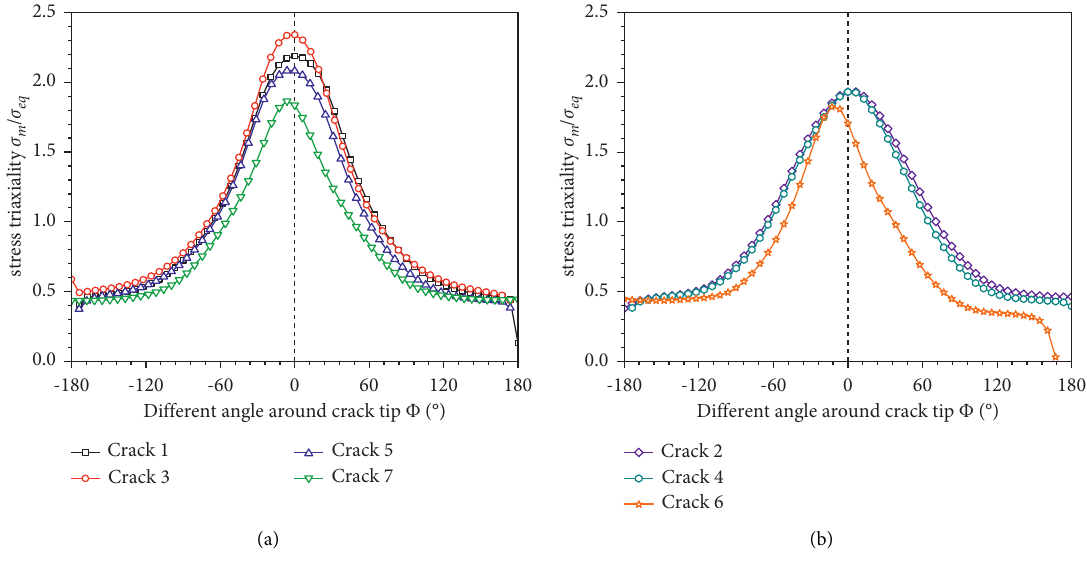
Figure 12: The stress triaxiality curve at the crack